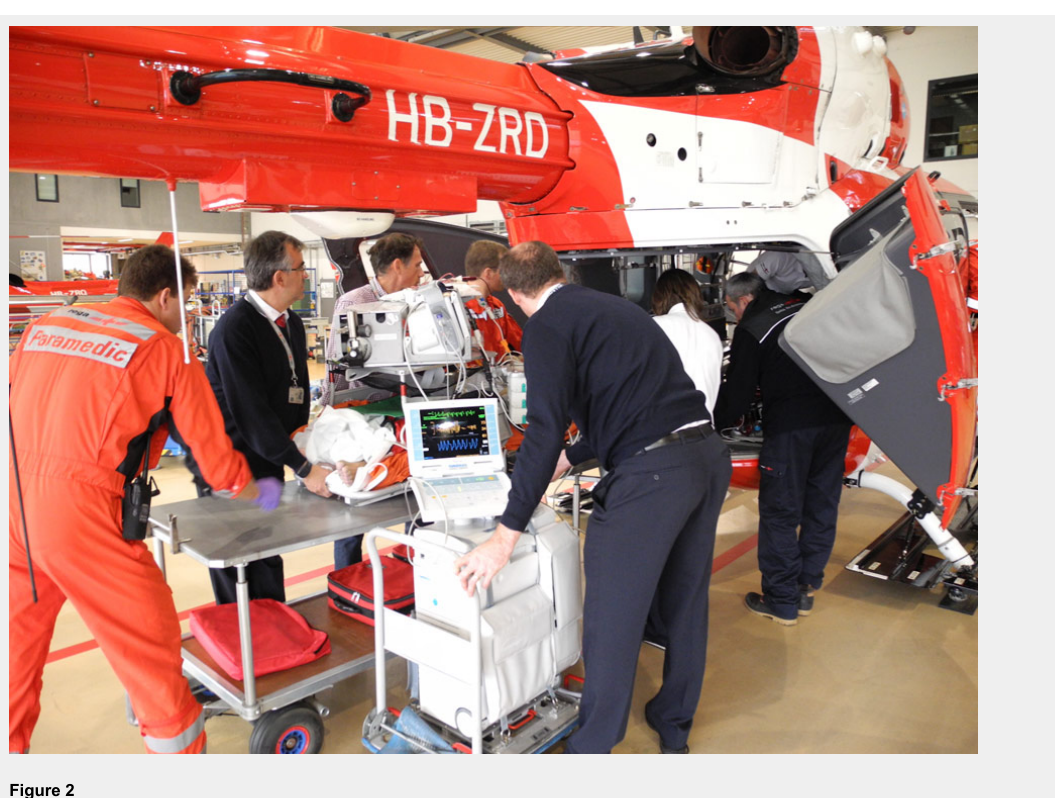
Positioning of patient, crew members and specific devices within the helicopter (back doors open). HCM: Helicopter Emergency Medical Services Crew Member; IABP: Intra-aortic balloon